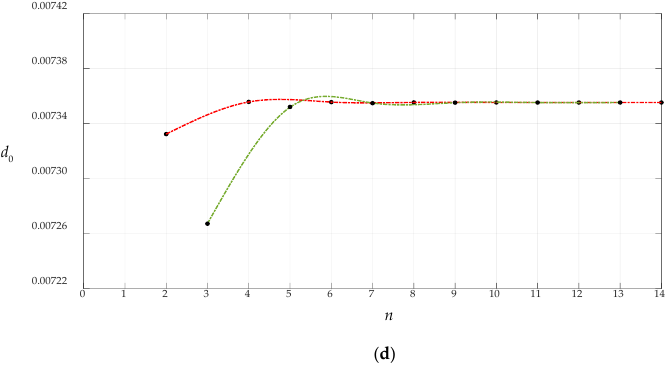
Figure 6. The variations of c 0 , c 1 , α , and d 0 with terms n , where the dash-dotted lines show the convergence trend of the data points of even terms ( n = 2, 4, 6…), the dashed lines show that of odd terms ( n = 3, 5, 7…), and where q = 1.725 × 10 −6 MPa: ( a ) the variation of α with n , ( b ) the variation of c 0 with n , ( c ) the variation of c 1 with n , and ( d ) the variation of d 0 with n .